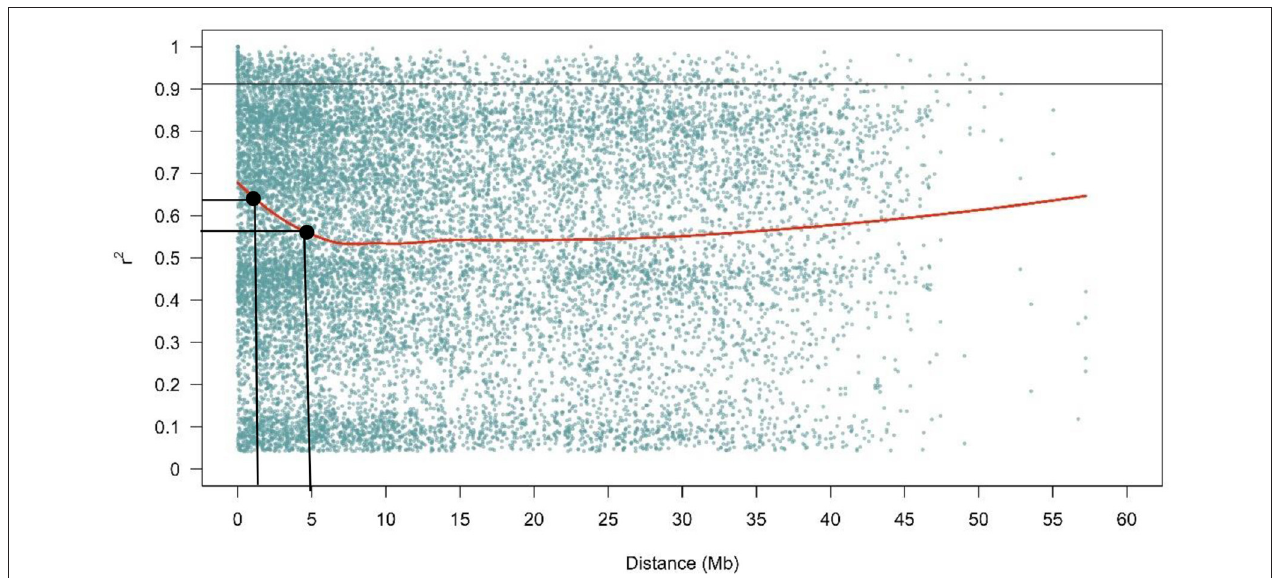
FIGURE 7 | The LD decay plot in the fonio diversity panel. The values on the Y-axis represent r ² while the X- axis constitute the physical distance in